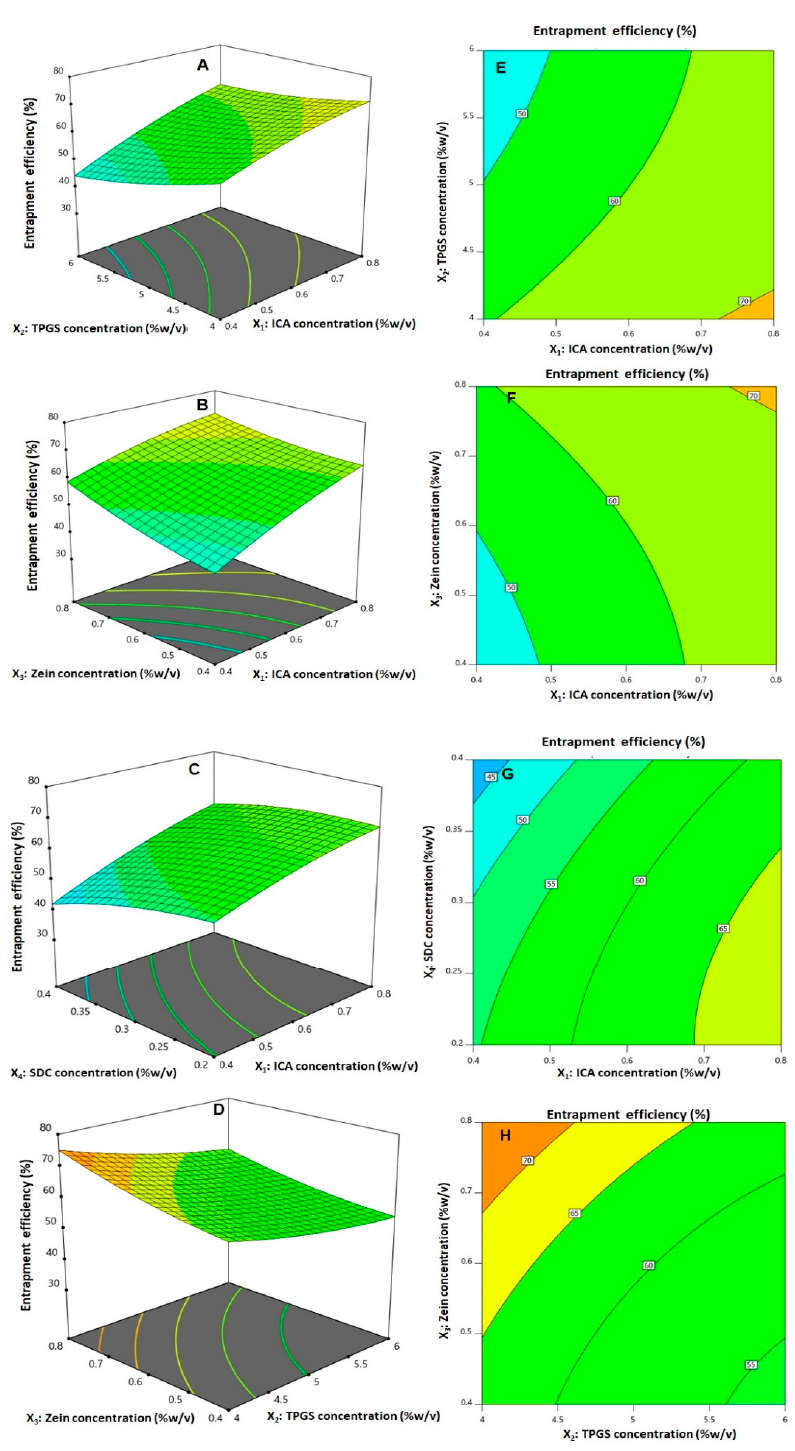
Figure 4. Response surface ( A – D ) and contour plots ( E – H ) displaying the interaction between the significant factors on the entrapment efficiency of ICA–tocozeinolate nanospheres.